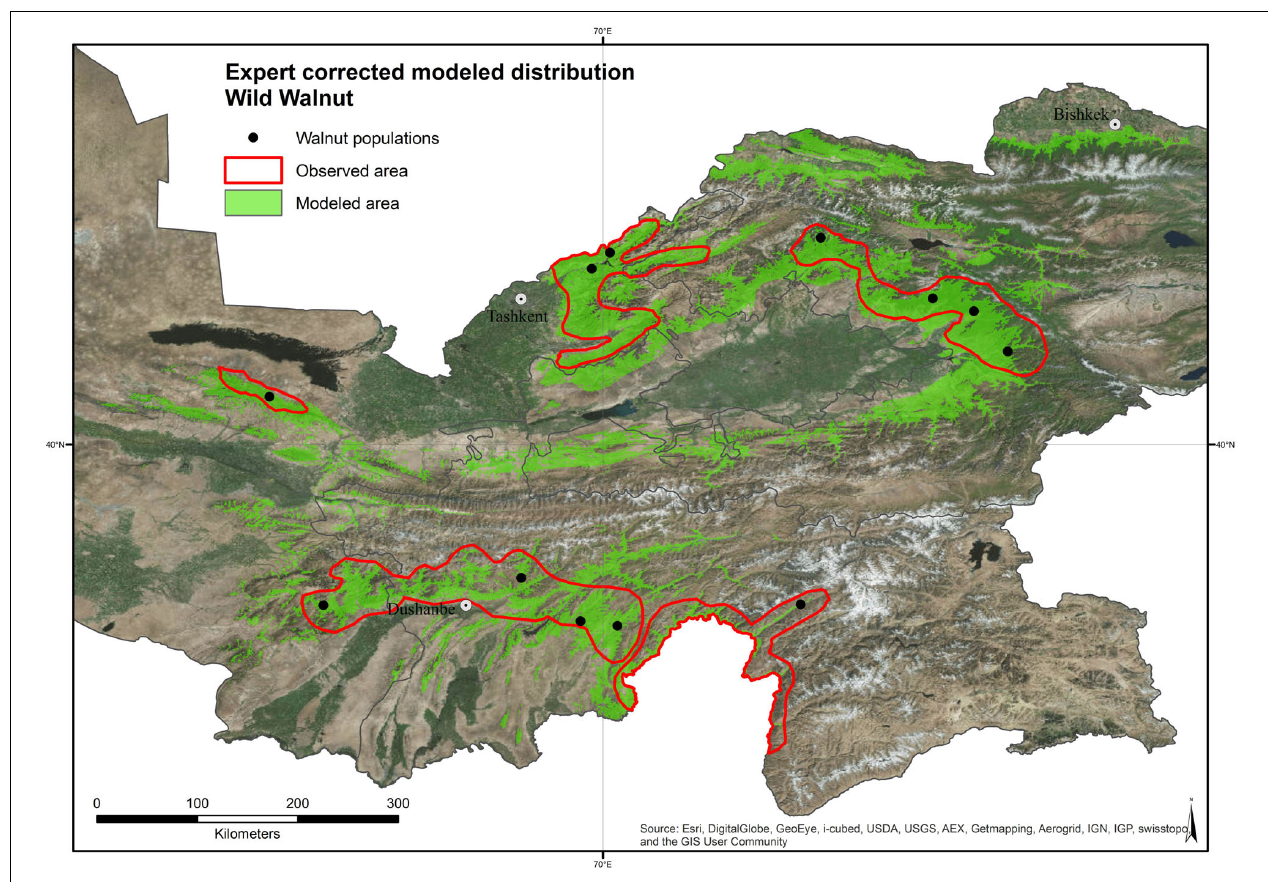
FIGURE 4 | Modeled and expert corrected distribution area of wild Juglans regia